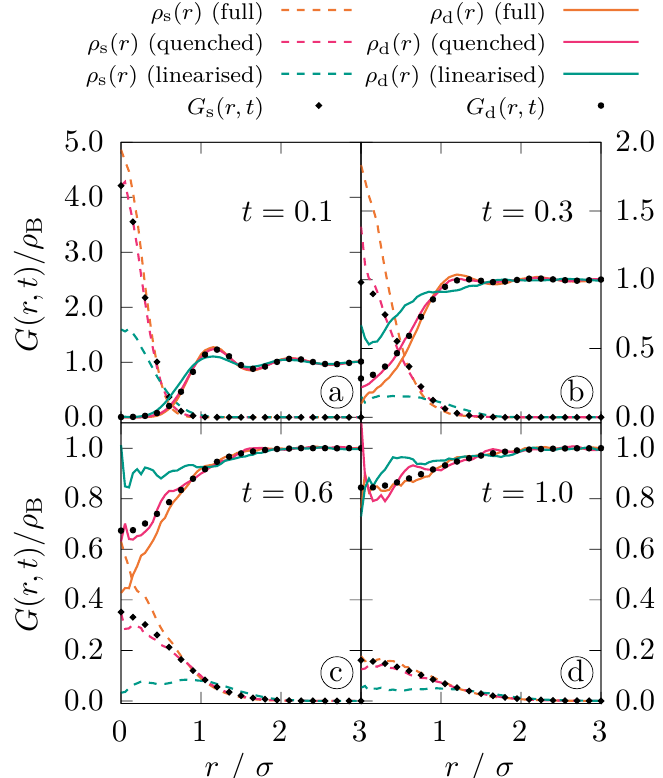
( r , t ) (black discs), s